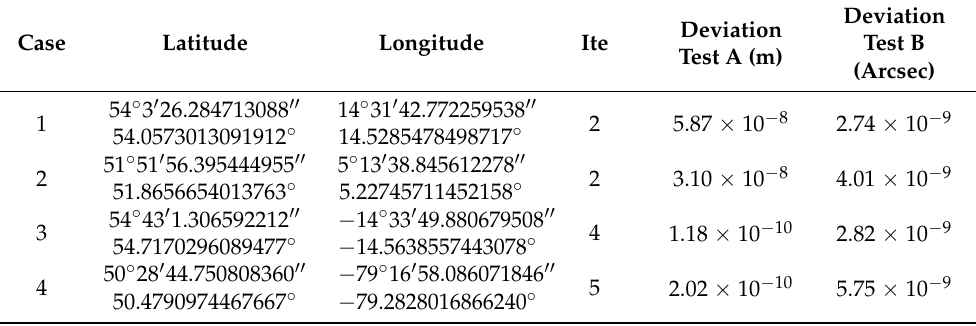
Table 3. Intersection of geodesics with an accuracy better than 100 nm using PostGIS through the STX_GeodesicIntersection new implemented SQL function. Values of latitude and longitude given in deg min sec as well as in decimal degrees. The column Ite is the number of iterations, the last column (Deviation) gives the computation of deviation with extended precision using the Maxima framework as explained in the next section.